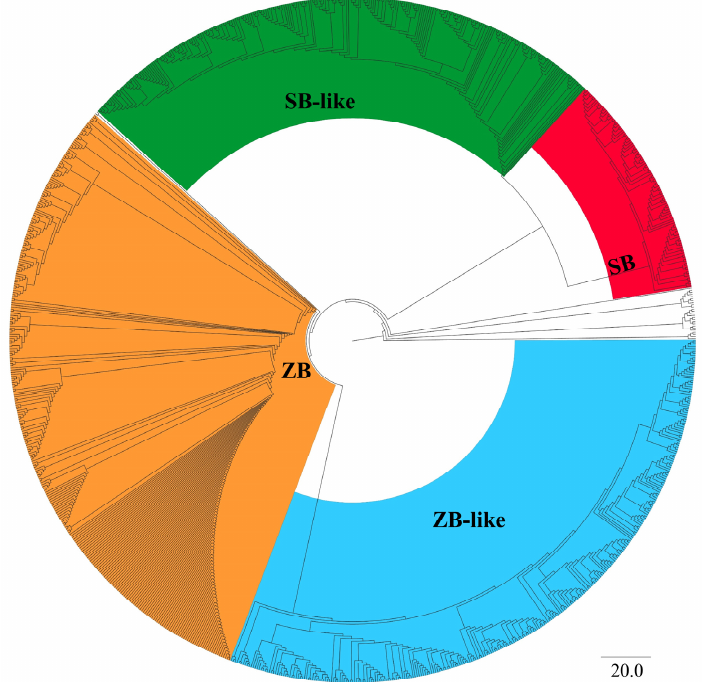
Figure 1. Phylogenetic analysis of SB and ZB elements. Bootstrapped (1000 replicates) phylogenetic trees were inferred using the maximum likelihood method in IQ-TREE (v. 1.6.12) [34]. Reference families were DD34E /Tc1 , DD36E /IC , DD37E /TRT , DD41D /VS , DD39D, and DD34D /mariner , DD37D /maT . DD37D /maT was used here as an outgroup. SB and ZB elements form a separate branch individually. The red and green parts in the figure represent the two branches that make-up SB elements, namely cluster SB and cluster SB -like, and the orange and blue parts in the figure represent the two branches that make-up ZB elements, namely cluster ZB and cluster ZB -like, with a confidence level of 100. See Supplementary Figure S1 for details.